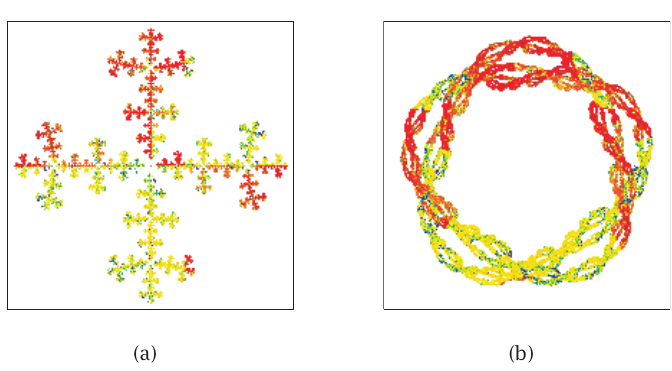
Figure 5.1 . Mixed Julia set (a), and Ochs’ example (b).